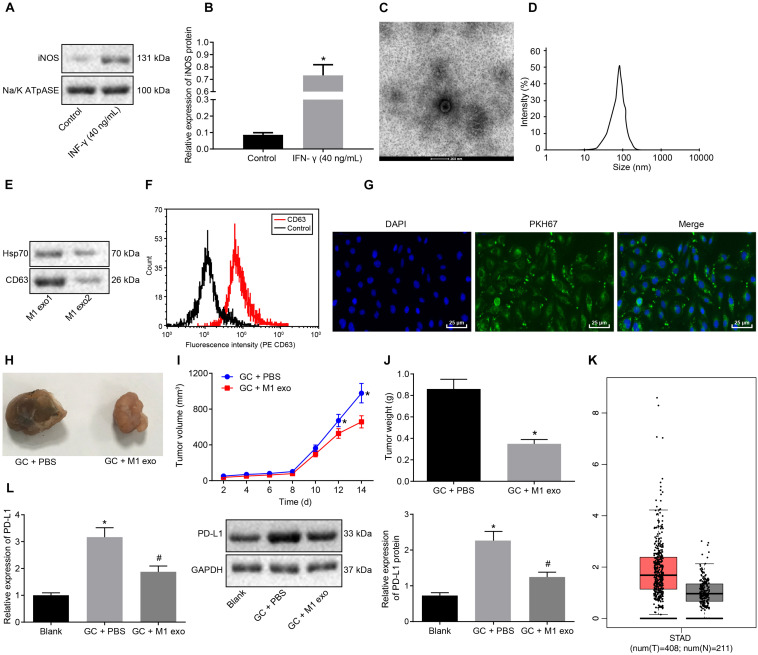
Exosomes derived from M1 macrophages suppress GC progression. (A) Western blot analysis of the cell surface marker iNOS protein expression in LPS (100 ng/ml) + IFN-γ (20 ng/ml)-induced macrophages (M1 macrophages) normalized to Na/K ATPase. (B) M1 macrophage membrane proteins quantified by image J and normalized with Na/K ATPase as well as statistics of iNOS gray value. (C) TEM observation of M1 macrophage-secreted exosomes (5,000×). (D) Dynamic light scattering detection of the diameter of exosomes. (E) Western blot analysis of the exosome surface markers (CD63 and HSP70) protein expression in M1 macrophages. (F) Flow cytometry of the exosome surface marker CD63 level. (G) Uptake of PKH76-labeled exosomes by GC cells was analyzed under a confocal fluorescence microscope (400×). (H) Tumor morphology in model mice with GC (n = 5). (I) Tumor volume in model mice with GC (n = 5). (J) Tumor weight in model mice with GC (n = 5). (K) Box plots of PDL1 expression in GC samples from TCGA analyzed by GEPIA (http://gepia.cancer-pku.cn/), wherein the left is GC tissues and the right is normal tissues, and the vertical axis is log2 [tags per million (TPM) + 1] (all PDL1 levels were normalized by TPM). (L) Western blot analysis of PD-L1 protein expression in model mice with GC normalized to GAPDH after protein quantitation by Image J (n = 5). *p < 0.05 compared with macrophages without the induction of IFN-γ or M1 exosome or mouse GC models without any treatment; #p < 0.05 compared with mouse GC models treated with PBS. Measurement data was representative of three independently conducted experiments and expressed as the mean ± standard deviation. Comparisons between two groups are analyzed by non-paired t test, and comparisons among multiple groups are analyzed by one-way ANOVA. Post hoc test is conducted using Tukey’s test.